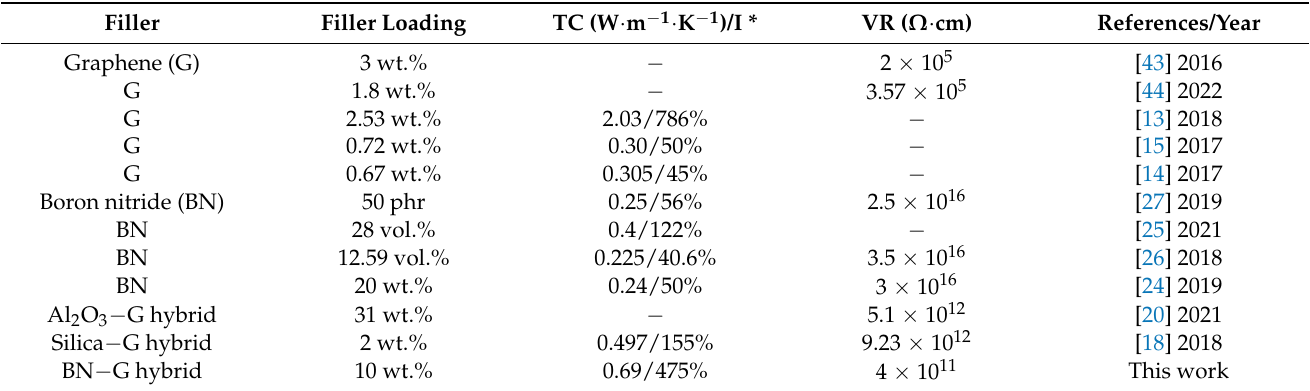
Table 1. Comparison of thermal conductivity (TC) and volume resistivity (VR) of the BN − MG/SR composite in this work with those of other SR − based